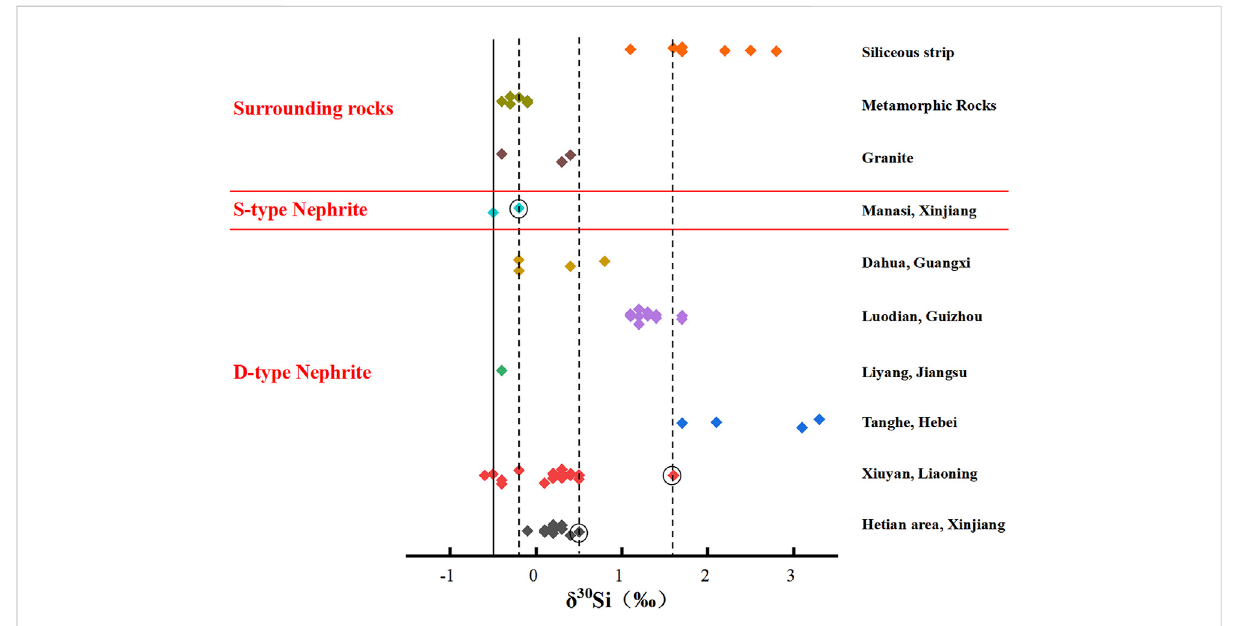
FIGURE 5 Silicon isotopic values of nephrite deposits in China (data in circles are silicon isotopic values of surrounding rocks of nephrite.).